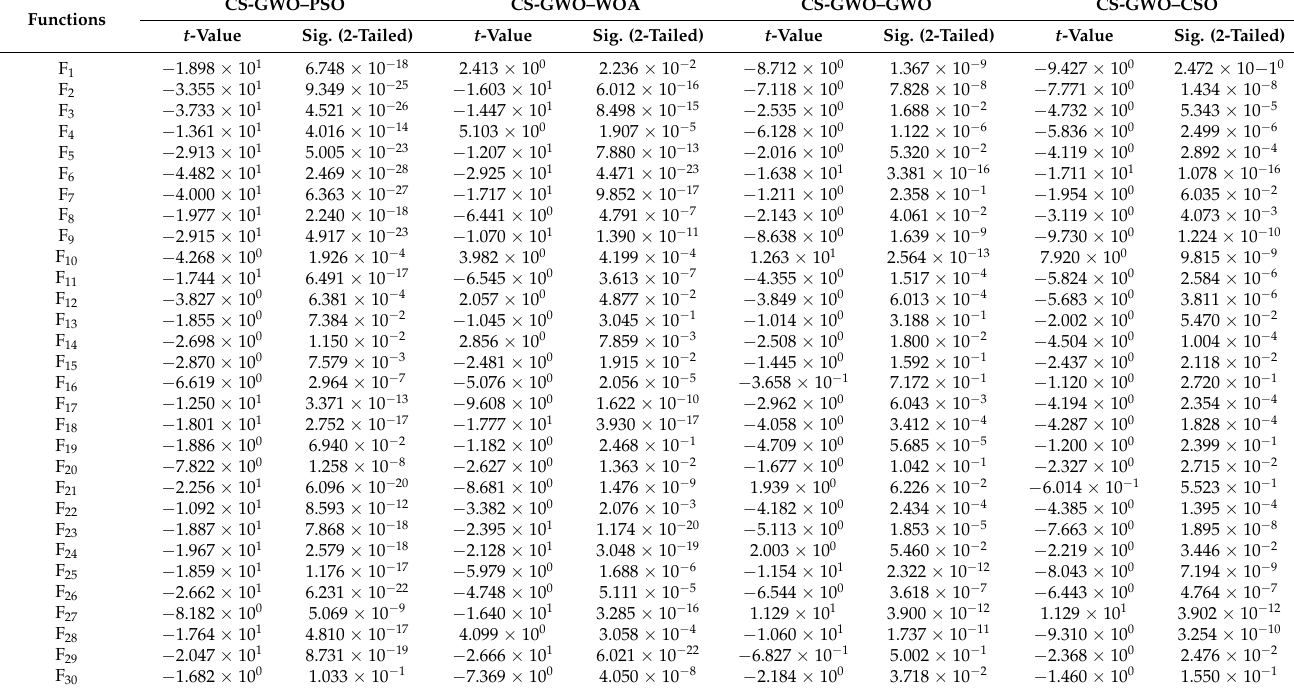
Table 3. The paired samples t -test results.